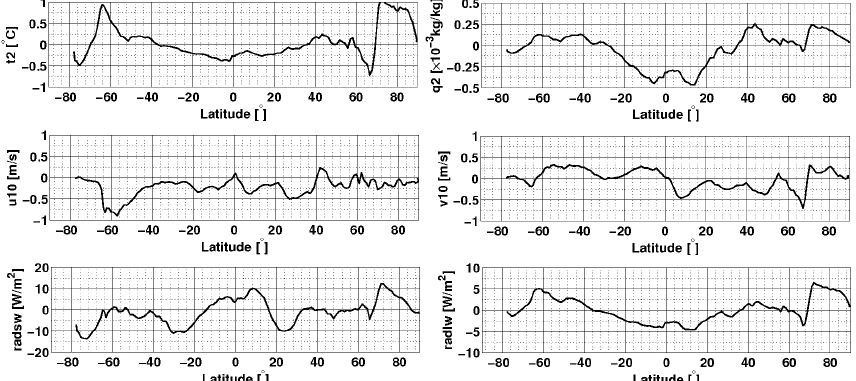
Fig. 5. 1989–2007 zonal mean computed corrections of temperature ( t 2 ), humidity ( q 2 ), zonal wind speed ( u 10 ), meridional wind speed ( v 10 ), downward shortwave radiation (rad sw ), and downward long-wave radiation